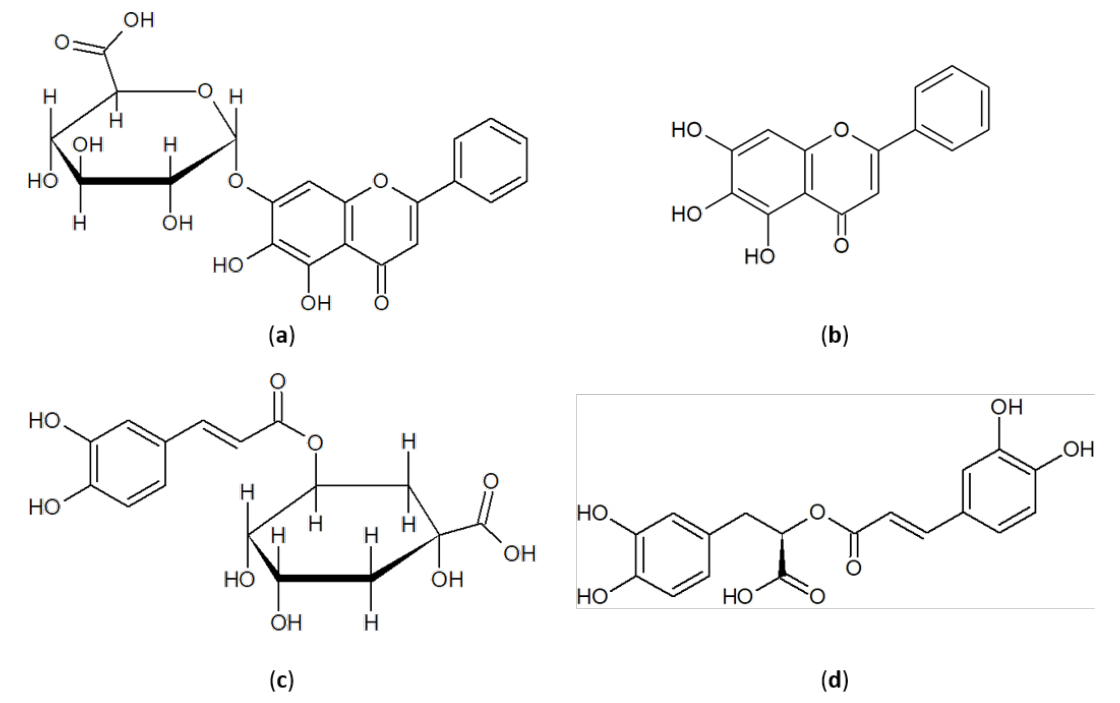
Figure 1. Molecular structures of polyphenols. ( a ) Baicalin — BA; ( b ) baicalein — E; ( c ) chlorogenic acid — CA; ( d ) rosmarinic acid — RA.